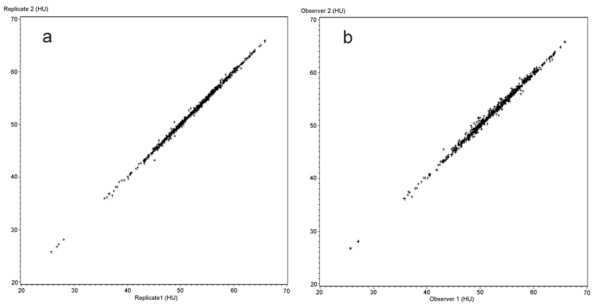
Mean attenuation in HU for all measured muscles. a) Intra-observer comparison, replicate 1 against replicate 2 both observers combined (n = 744) and b) Inter-observer comparison, observer 1 against observer 2, both replicates combined (n = 744).